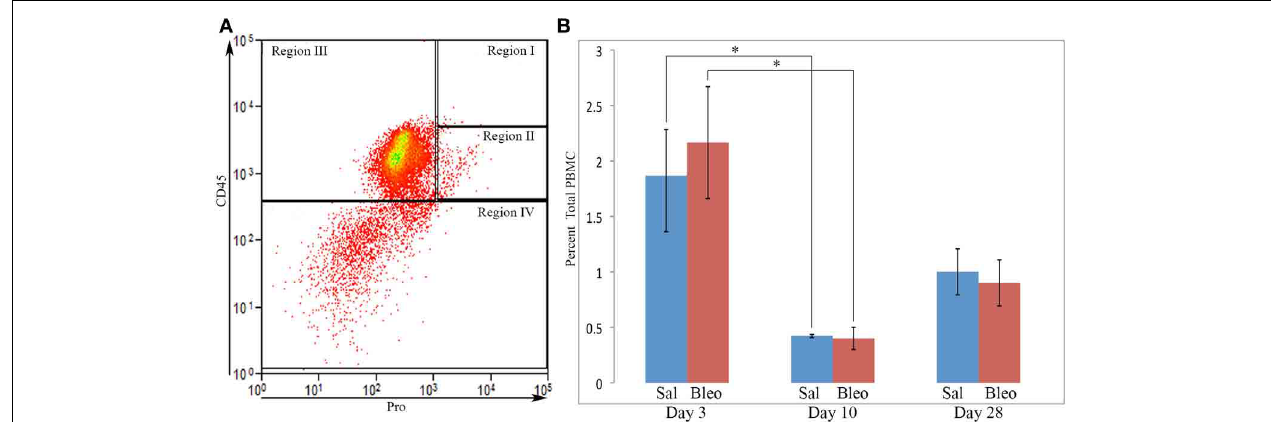
FIGURE 9 | Circulating fibrocytes. (A) PBMC from a bleomycin-treated mouse sacrificed 28 days after initiation of treatment were immunolabeled for CD45 and Pro. A scatter plot is presented with CD45 on the y-axis and Pro on the x-axis showing almost no cells in Region I, few cells in Region II, and that, even among the few cells present in Region II, almost none were in the upper half of Region II where almost all lung cells in Region II are located.